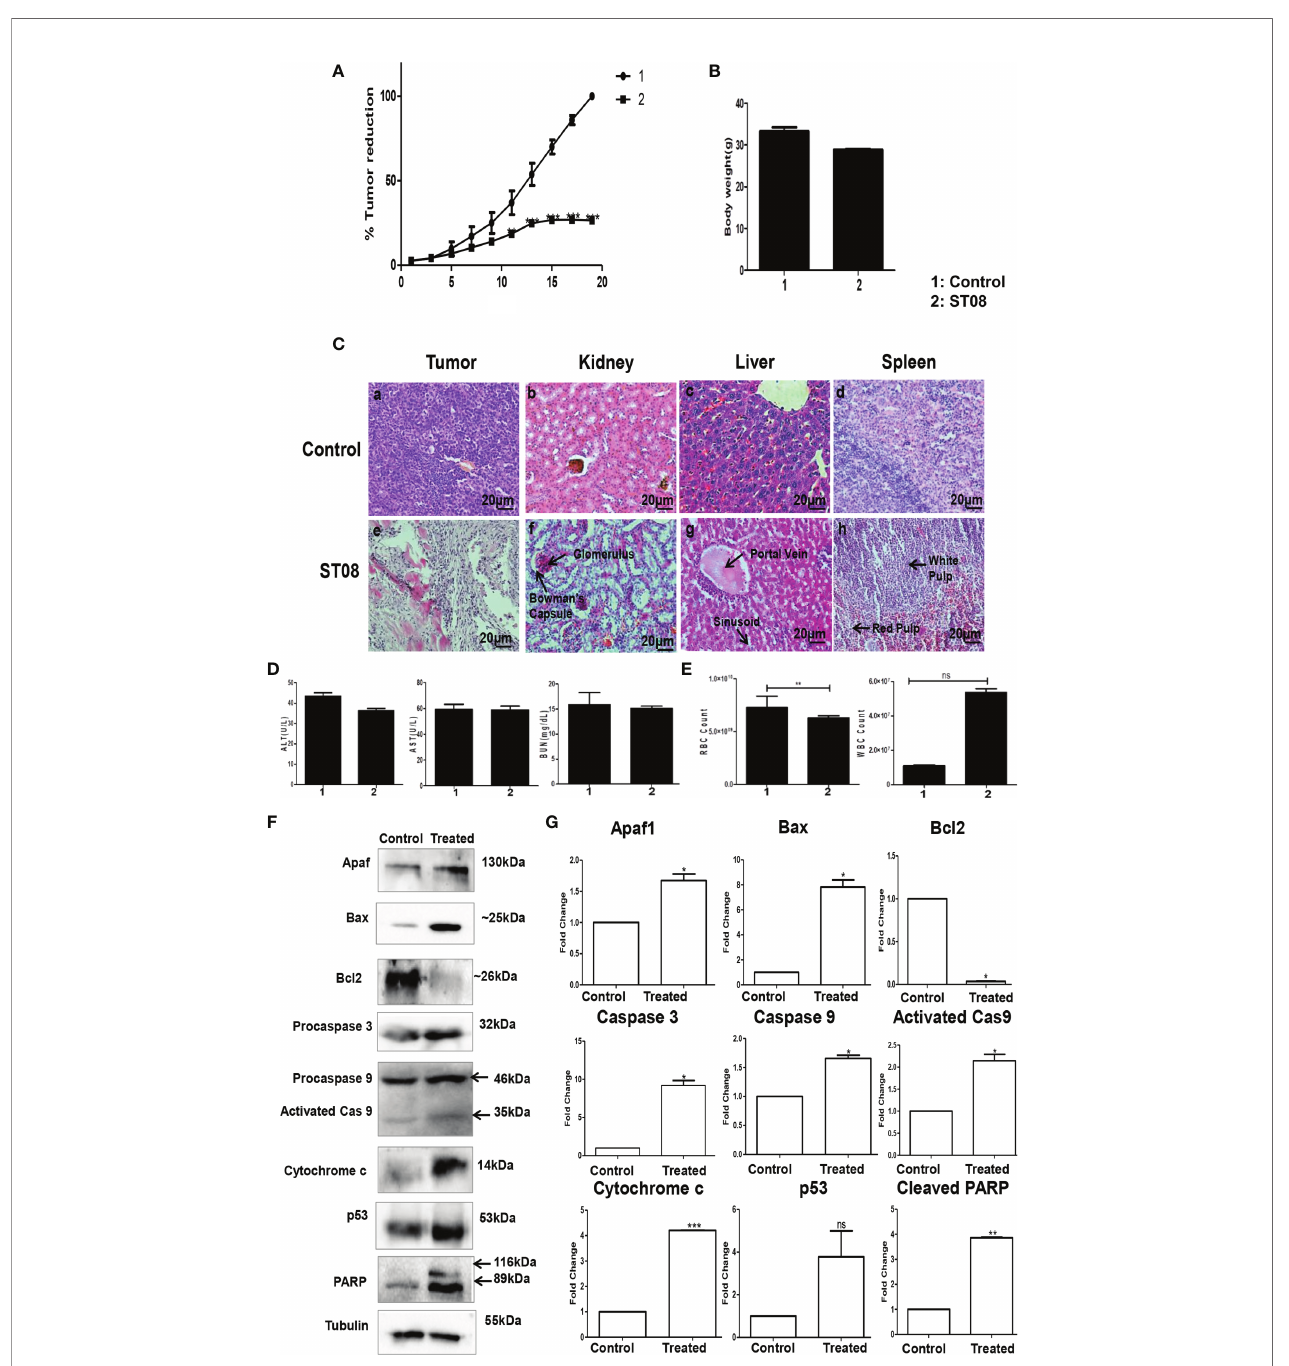
FIGURE 3 | Evaluation of the effect of ST08 on tumour growth: EAC cells (1 x 10 6 cells/animal) were injected to induce solid tumours. After the 7 th day of injection, i.p injection with ST08 (20mg/kg bd.wt) was started every alternate day throughout the experiment. (A) % Tumour volume reduction after ST08 treatment. (B) Body weight of animals at the end of the study. (C) Histopathological analysis of tumour and organs after ST08 treatment. At the end of the study, tumour tissue and organs were collected and used for histological analysis — representative images of H&E stained sections at 20X magni fi cation of (a) control tumour, (e) ST08 treated tumour (b) control liver, (f) ST08 treated liver (c) control spleen, (g) ST08 treated Spleen (d) control kidney, (h) ST08 treated kidney. (D) Blood ALT, AST, Urease test results are plotted as bar graphs. Blood was collected at the end of the study. (E) WBC and RBC counts of experimental animals are plotted as bar graphs. (F) Effect of ST08 on the expression of apoptotic proteins in the tumour tissue of experimental animals. Tissue lysates were prepared from the dissected tumour samples of post treatments. 40 µg of protein was loaded in SDS-PAGE and checked for apoptotic protein expression by western blotting. (G) Quanti fi cation was done for each marker and is represented as a bar graph of mean +/- SEM. One sample t-test was performed, and the p-value was calculated between control and ST08 treated groups (*: p -value <0.05, **: p -value <0.005, ***: p -value < 0.001, ns, not signi fi